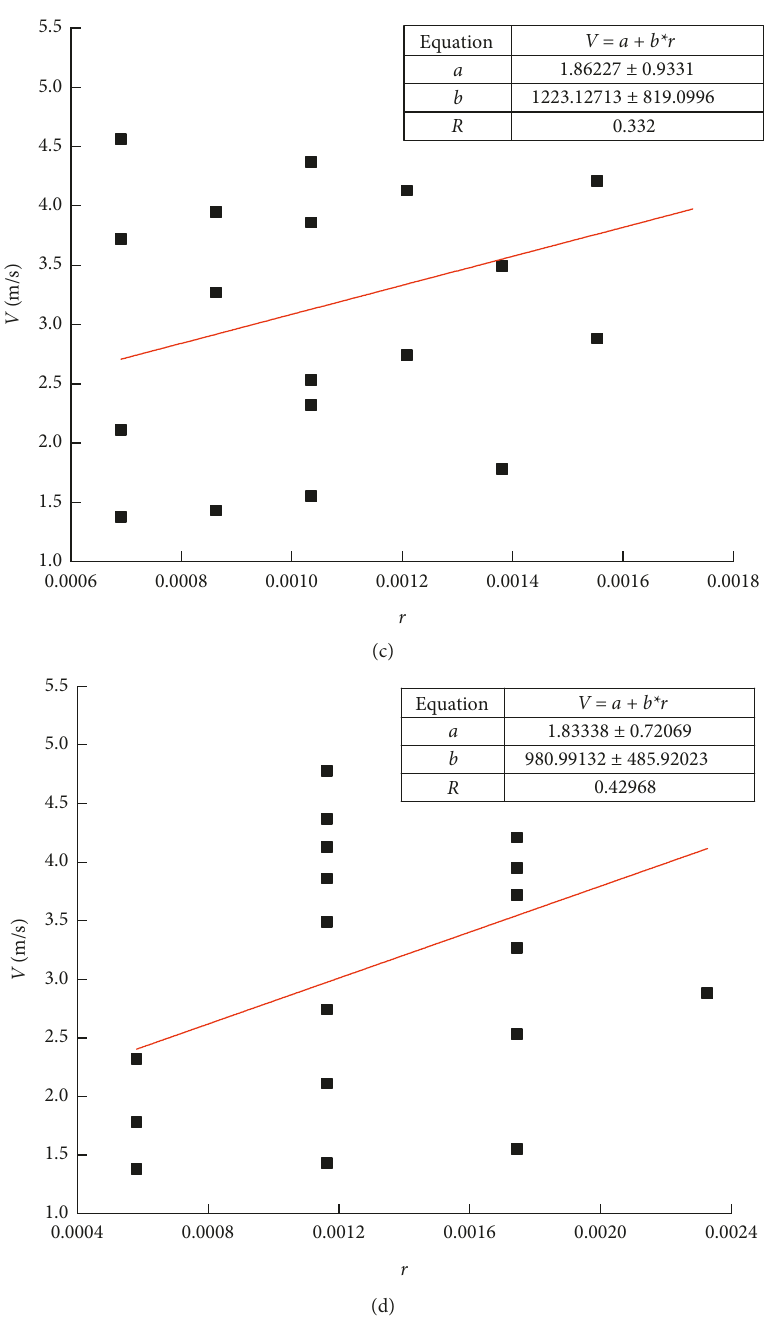
Figure 11: Graphs of linear fitting of r and V . (a) Ride-hailing vehicles. (b) Private cars. (c) Taxis. (d)